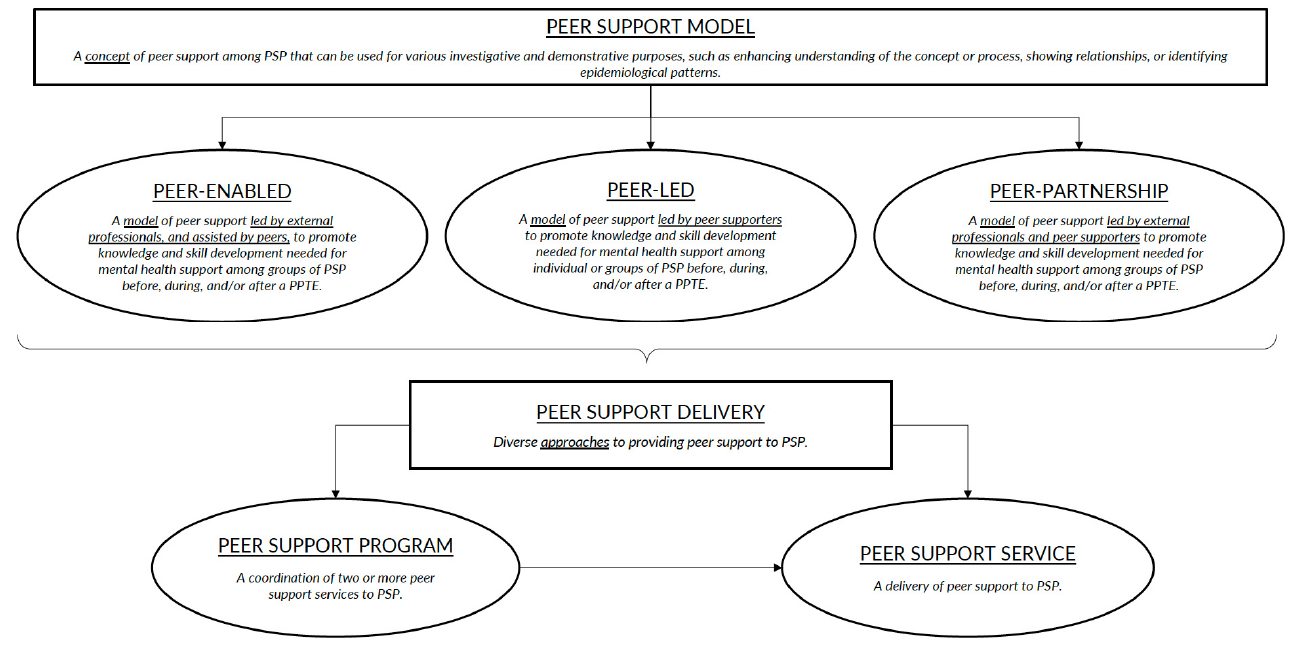
Figure 1. A diagram towards a typology of peer support. Table 2. Models of peer support as delivered by each organization. Peer-Enabled Peer-Led Peer-Partnership Tend Academy Ltd. 911 Resilience The ICISF Canadian Mental Health Association Wayfound Mental Health Group (OSI-CAN; Resilient Minds) Wounded Warriors Canada Department of National Defence The IAFF Mood Disorders Society of Canada Prairies to Peaks Consulting Inc.